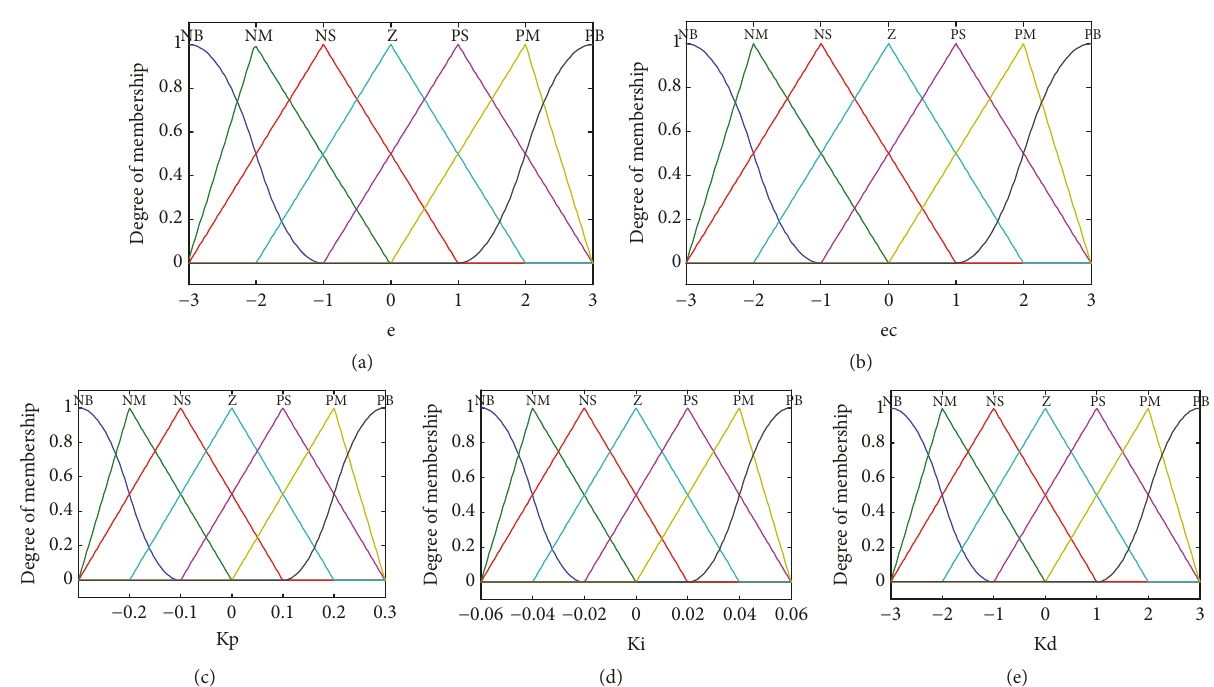
Figure 4: The subjection function of variables. (a) is the error ( 𝑒 ); (b) is the error change ( 𝑒𝑐 ); (c) is the parameter 𝑘 𝑝 ; (d) is the parameter 𝑘 𝑖 ; and (e) is the parameter 𝑘 𝑑